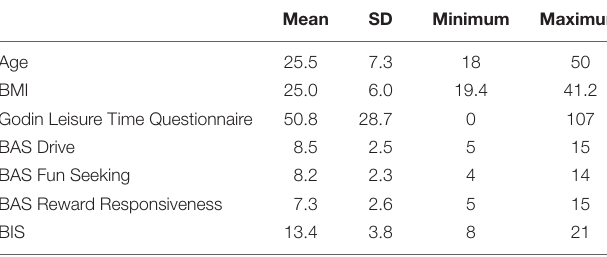
TABLE 1 | Study 1 sample characteristics ( n =